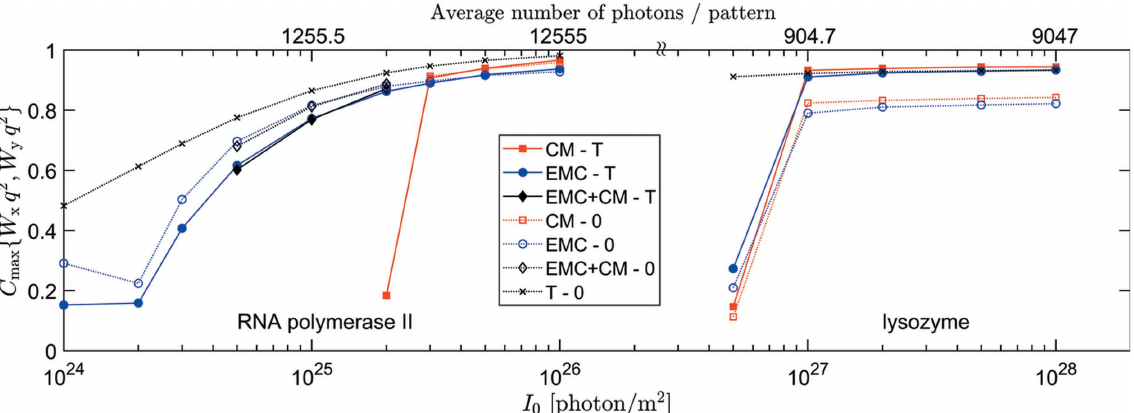
Figure 5 The maximums of Pearson correlation between intensity volumes W x and W y as rotated relative to each other, for lysozyme (right) and RNA polymerase II (left) at various incident XFEL fluence values. The upper scale (number of photons per pattern) is different for the two molecules. W x denotes the intensity distribution reconstructed by either EMC (blue circles), CM (red squares), a combination of them (black diamonds, see the main text for details) or using the true orientations (black crosses). W y refers to the reference intensity distributions W T (full symbols and solid lines) or W 0 (empty symbols and dotted